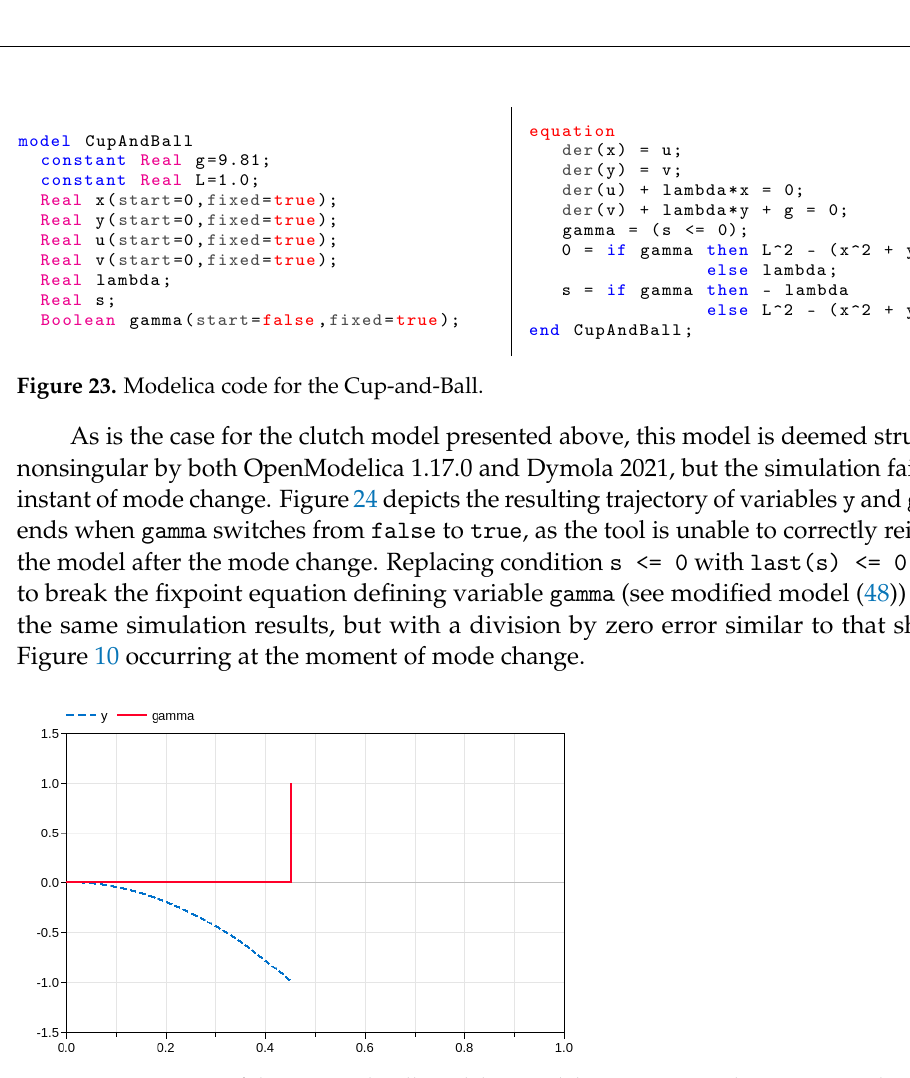
Figure 24. Trajectory of the Cup-and-Ball Modelica model: it stops around t = 0.452 s, when the rope becomes